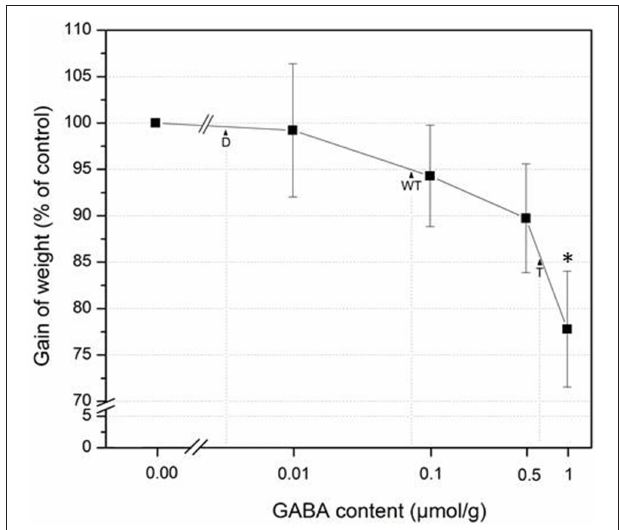
FIGURE 3 | Feeding assay of Spodoptera littoralis larvae on Arabidopsis wild-type (WT), gad1/2 and gad1/2 x pop2-5 plants. S. littoralis 1st instar larvae were pre-weighed and three larvae were placed on each plant. The larval weight (mean ± SE) was measured after 7 days of feeding. The total number of larvae weighed (N) is indicated in the bars. Experiments were repeated four times independently. Statistically significant differences between WT and GABA mutant plants after feeding were analyzed by One-way ANOVA ( p < 0.05 , SNK-test) and are indicated by different letters.